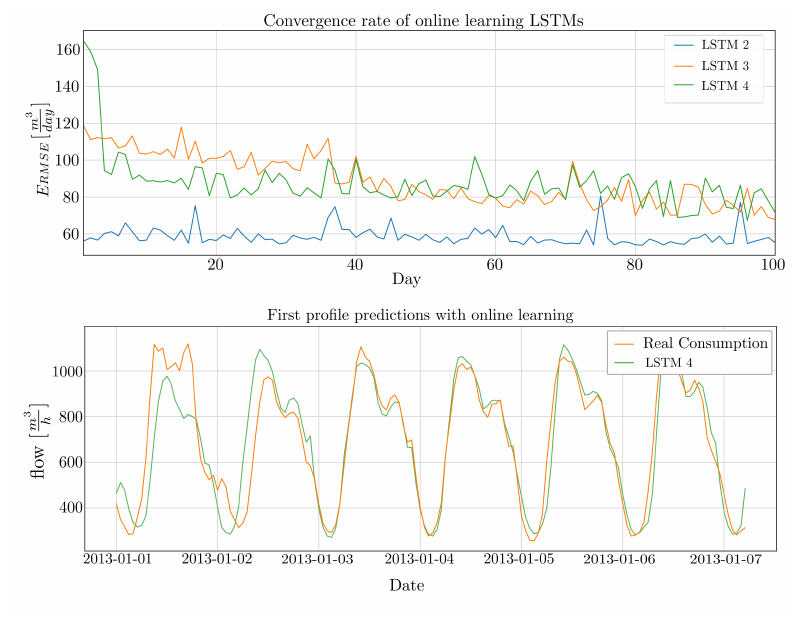
Figure 8. Results of online learning using three types of LSTMs. Upper plot: convergence of the different LSTMS. Lower plot: First predicted consumption profiles from the LSTM doing online learning “on the